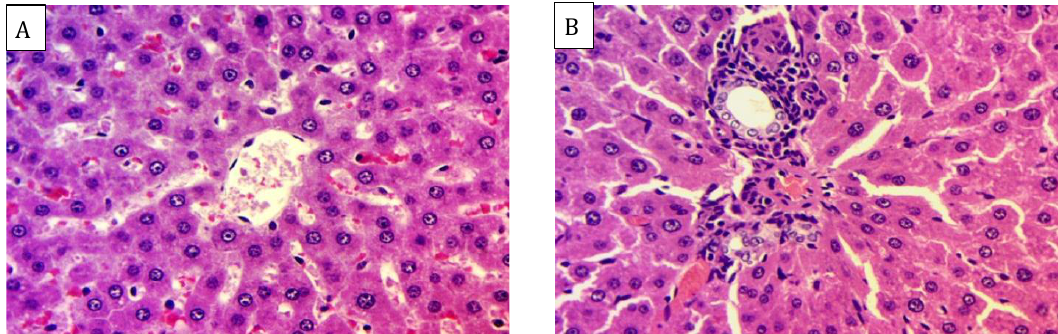
Figure 4 . Liver sections of rats fed on 1% cholesterol diet and treated orally with methanolic extract of green walnut husk, 400 mg/kg BW/day (Group 4). A: Mild hepatocellular swelling and focal infiltration with mononuclear inflammatory cells. B. Bile duct hyperplasia and focal infiltration by mononuclear inflammatory cells. H&E, 400×